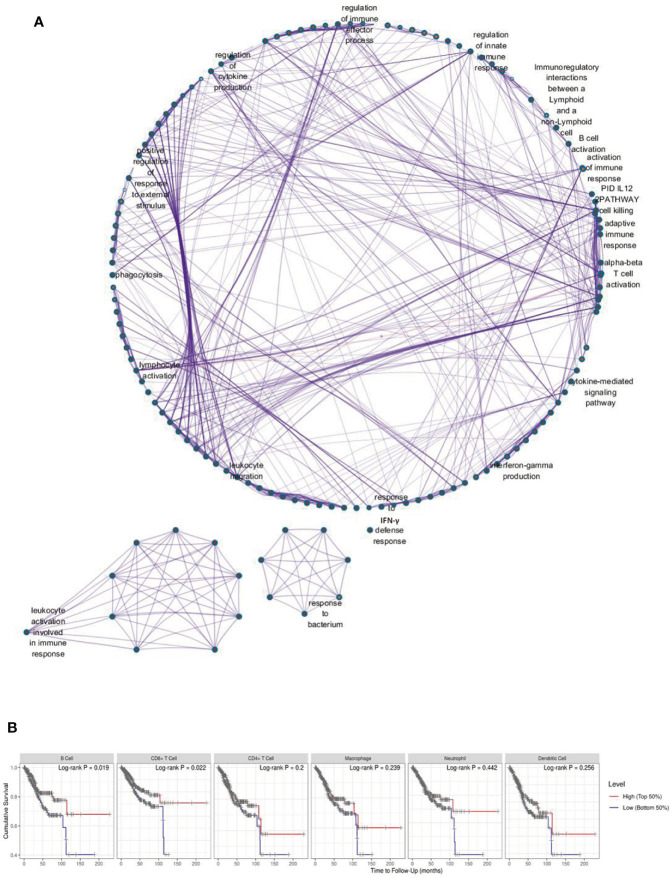
Immune Scores and Enrichment Analysis of DEGs in EC. (A) The correlation between high immune score related differentially expressed genes (DEGs) and biological processes GO terms; (B) The tumor infiltration with six types of immune cells and cumulative survival rates.